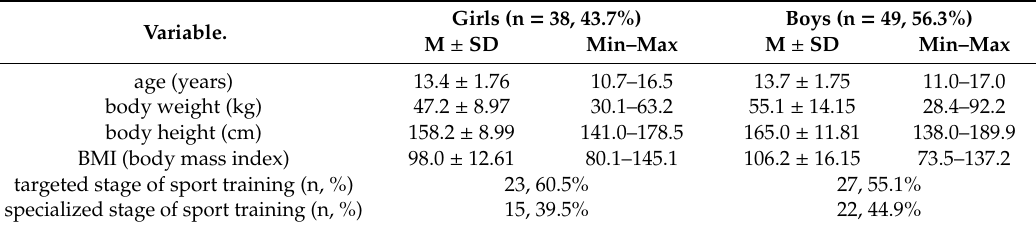
Table 1. Demographic characteristics of the players.